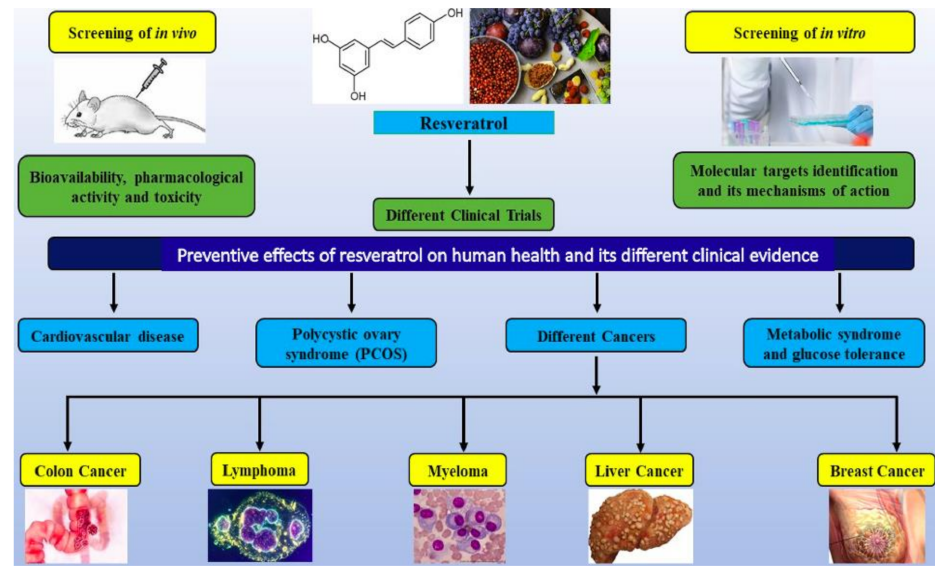
Figure 4. The preventive effect of resveratrol on human health in vitro, in vivo, and clinical